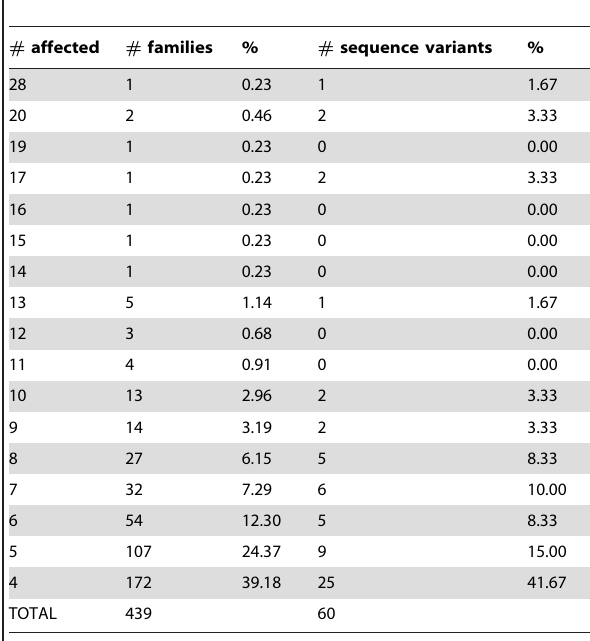
Table 1. Distribution of the families by the number of affected individuals in each family.